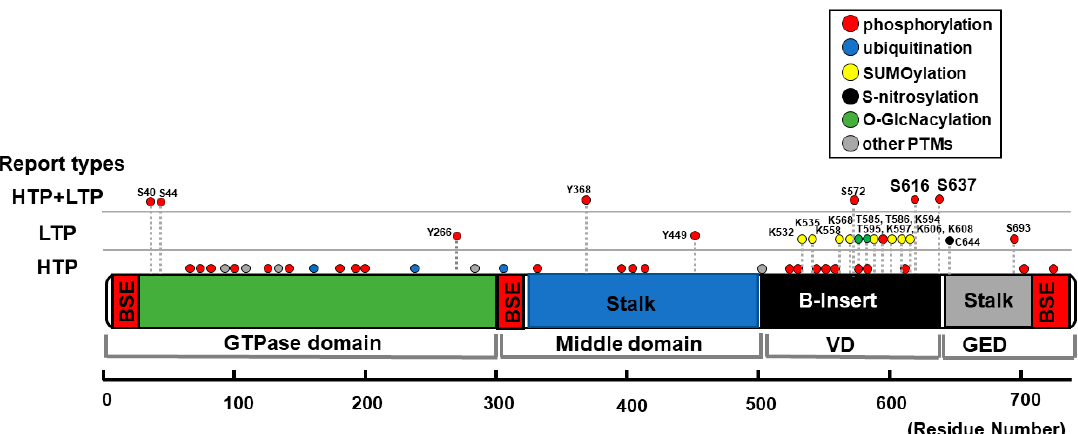
Figure 2. Schematic diagram of DLP1 structure and distribution of PTMs. Structure-based domain architecture of human DLP1 isoform 1 is depicted by the modified information of DLP1 isoform 2 from Fröhlich et al. [100]. If the publication record(s) is (are) only from proteomics and mass spectrometry data (“high-throughput papers” [HTP]), these sites are shown as HTP. The HTP information was collected from PhosphoSitePlus [102]. If the function of the specific site is investigated by methods other than high-throughput mass spectrometry (e.g., mutagenesis), then these records are categorized as “low-throughput papers” (LTP). If both low- and high-throughput records exist, then these records are shown as HTP + LTP. All the reports from LTP are summarized in Table 1. “Other PTMs” include acetylation, methylation, and proteolytic cleavage. If the information is from rat and mouse DLP1, site numbers are shown as the orthologous sites in human. BSE, bundle signaling element; GED, GTPase effector domain; VD, variable